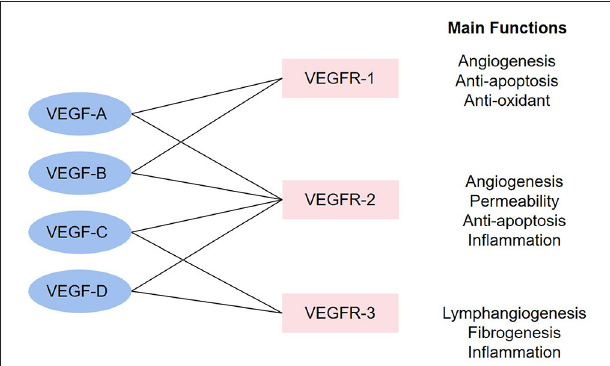
FIGURE 1 | The combinations in the VEGF family and main functions. The linkage between VEGF factors and VEGFR represents that the factors can combine with the receptors. The main functions stand for the functions after the activation of each